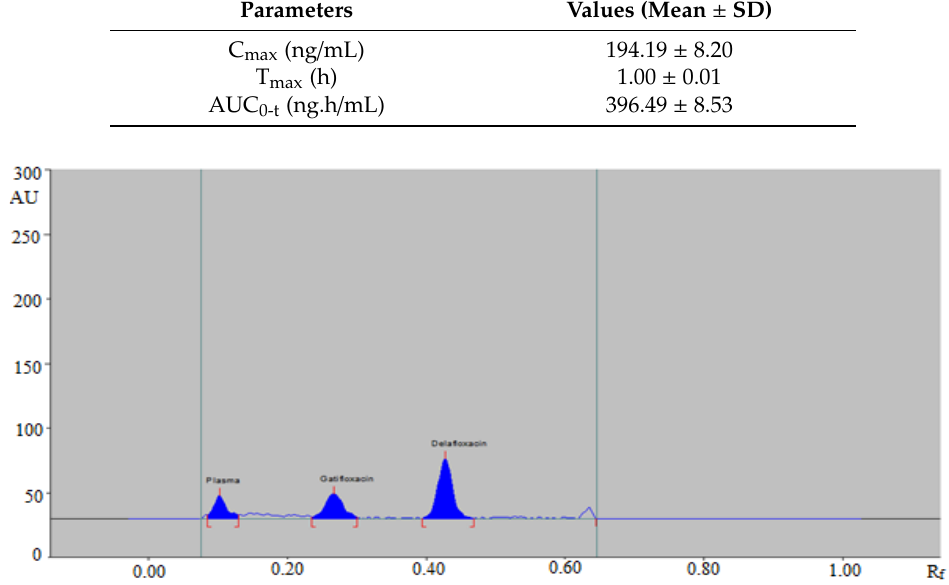
Table 6. Pharmacokinetic parameters of DLX after an oral administration of single dose (20 mg / kg) in rats ( n = 6).